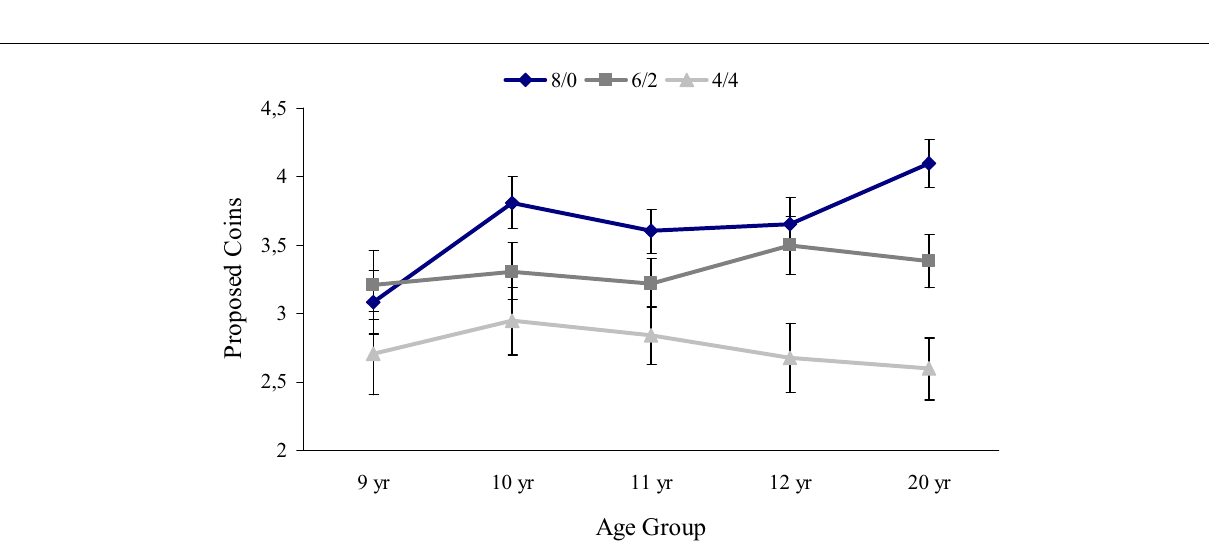
coins offered in the hidden information condition 8/2 ( r =